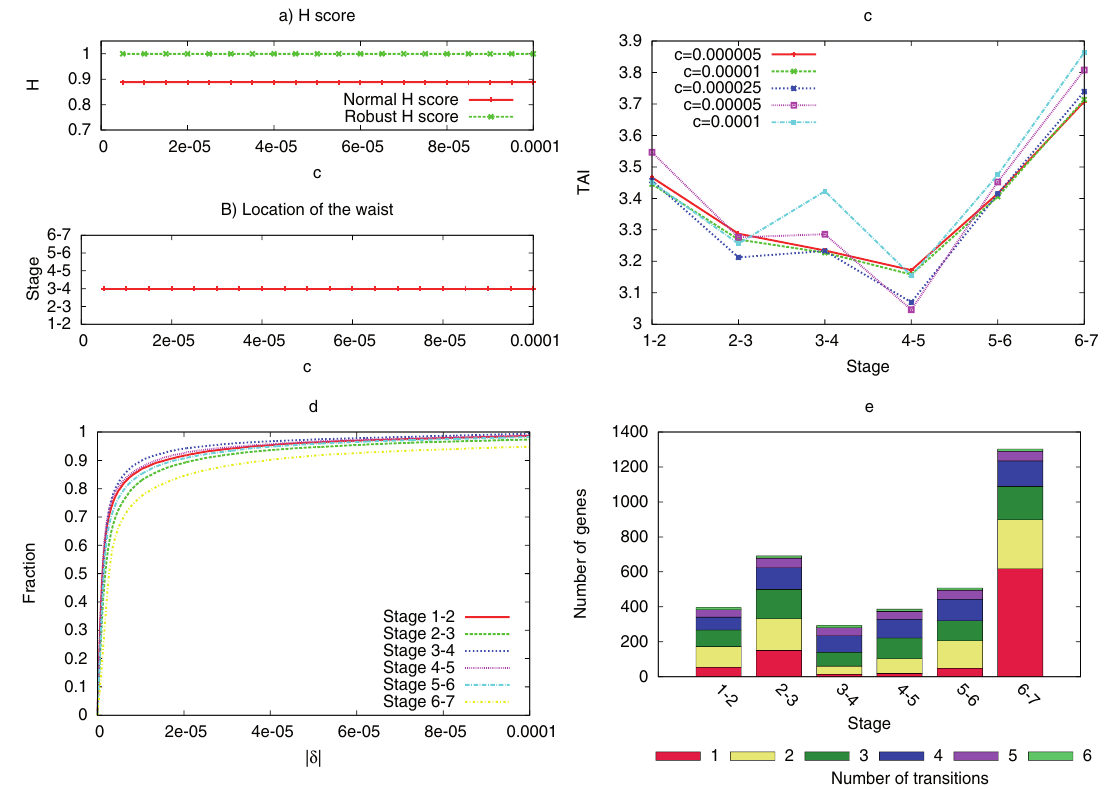
Figure 13. Arabidopsis thaliana results using normalized expression levels. Graph ( a ) shows the hourglass score (normal and robust) as a function of the transition threshold c . Graph ( b ) shows the location of the hourglass waist (stage-pair) as a function of the transition threshold c . Graph ( c ) shows the Transcriptome Age Index of transitioning genes for five different values of c (chosen so that the number of genes with known age index assigned to each stage-pair is at least 290). Graph ( d ) shows the CDFs of the expression level absolute variations | δ | across successive stage-pairs. Note that in this case the hourglass waist (in terms of number of transitioning genes) appears in stage- pair (3,4), while the oldest genes appear in the next stage-pair. Graph ( e ) shows the transitioning genes with c = 0.0001. The transitioning genes constitute 7% of all genes in that dataset. 49% of those genes transition in a single stage-pair. Of the remaining, 36% transition only in consecutive